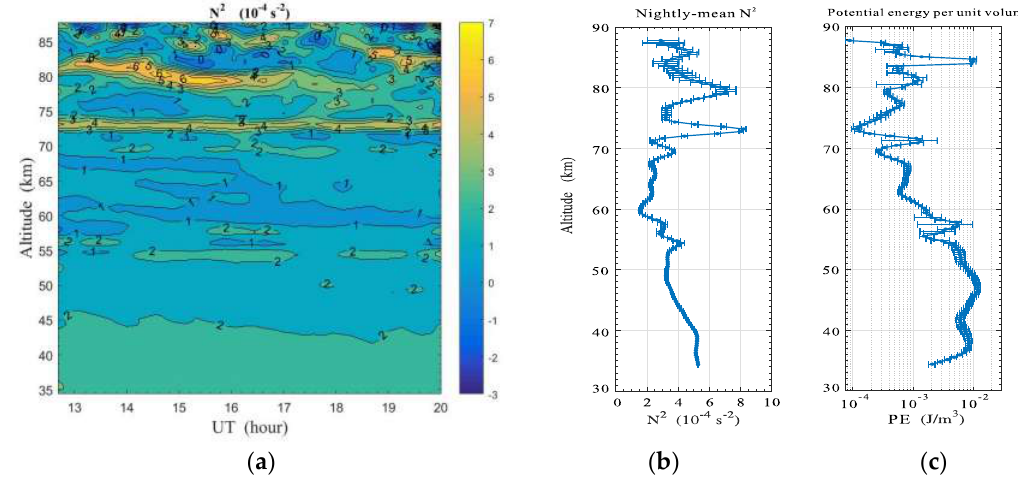
Figure 10. ( a ) Time-altitude variation of the Brunt-Väisälä frequency N 2 , ( b ) nightly mean N 2 profile, and ( c ) nightly mean profile of AGW potential energy per unit volume. The horizontal bars represent standard deviations.